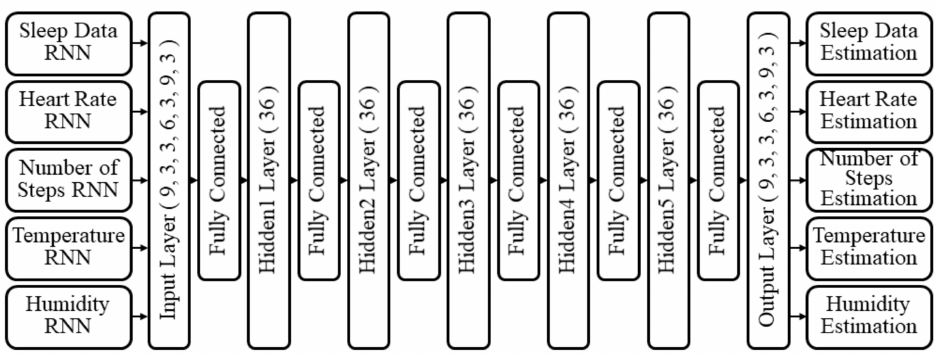
Figure 4. Structure of the proposed multimodal deep learning for estimating missing values.